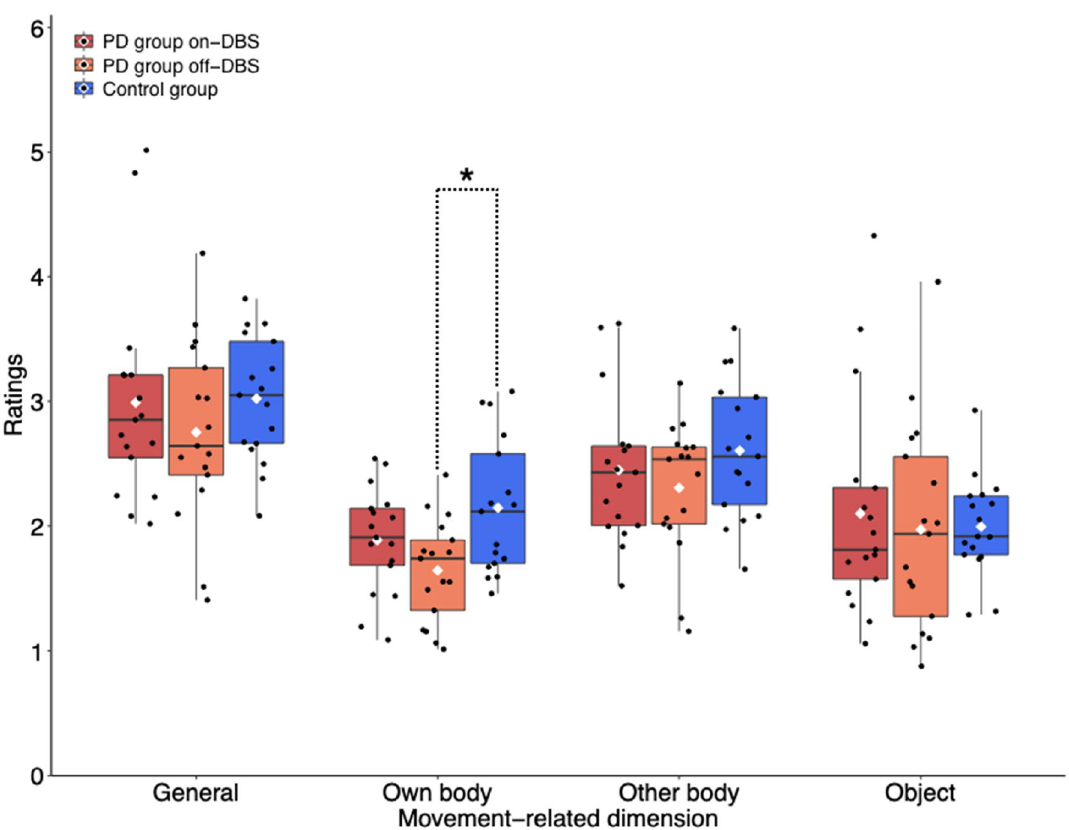
Figure 1. Ratings for the different dimensions of motor-relatedness of produced words per group and condition. Boxplots indicate the mean, upper and lower quartiles, and range. Dots display the individual means of the participants. The significant difference between groups is marked with an asterisk ( p < .05). Note, that the full rating scale ranged from 0 to 10, however, the y-axis is abbreviated for a better display of the results, which only included mean ratings up to 5. The statistical analysis was conducted for the logarithmically transformed